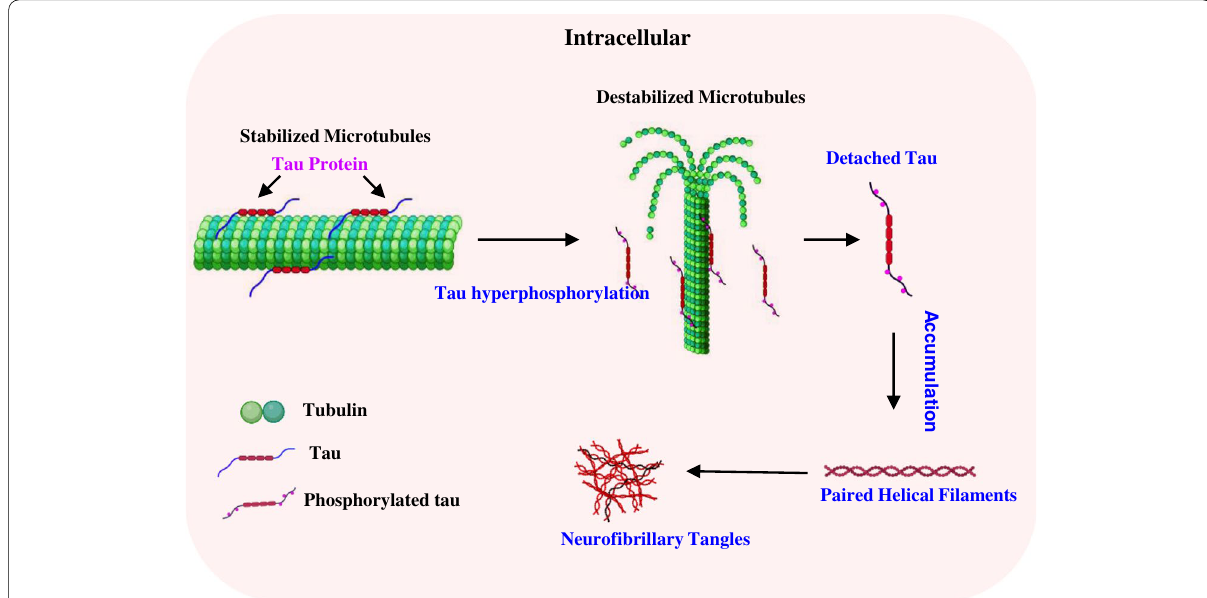
Fig. 2 Diagram of the formation of neurofibrillary tangles. Under normal conditions, tau binds to the microtubules facilitating microtubule assembly and promoting microtubule stabilization. In AD, the abnormally phosphorylated tau dissociates from the microtubules, and the phosphorylated tau proteins form neurofibrillary